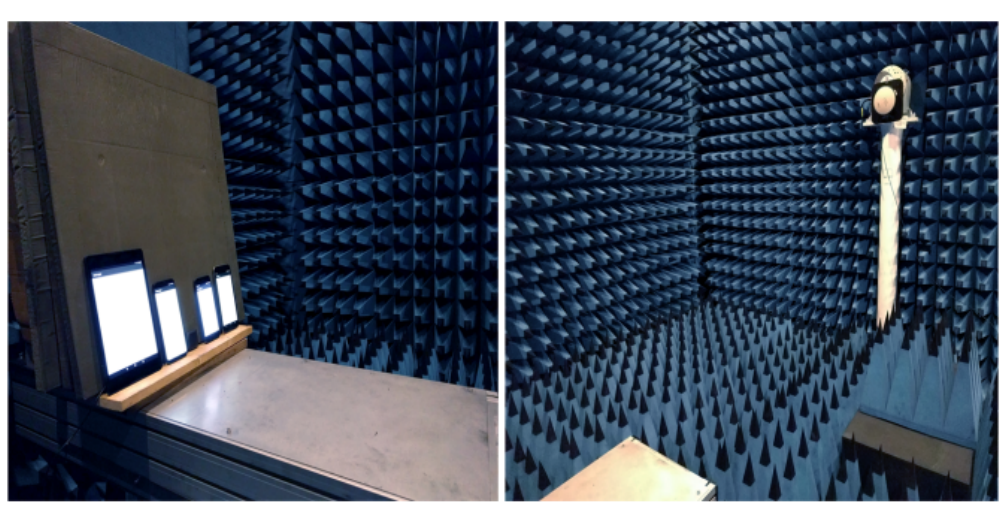
Figure 6. Anechoic chamber setup: on the left, receivers in face-up orientation; on the right, the transmitting GNSS